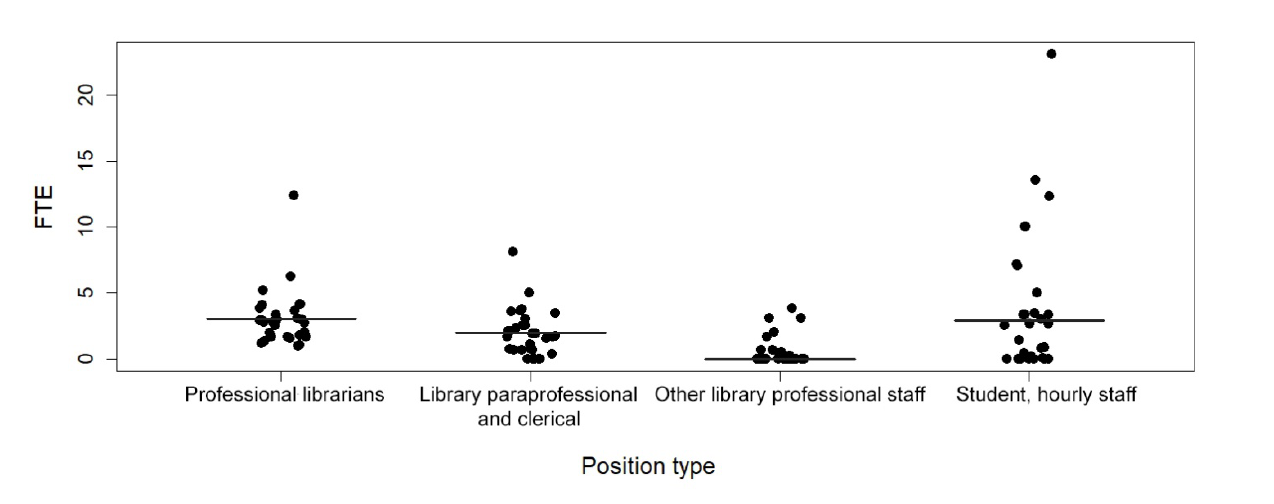
Figure 2 Median (lines) and individual (dots) library staffing per 1,000 students by employee position type in COM